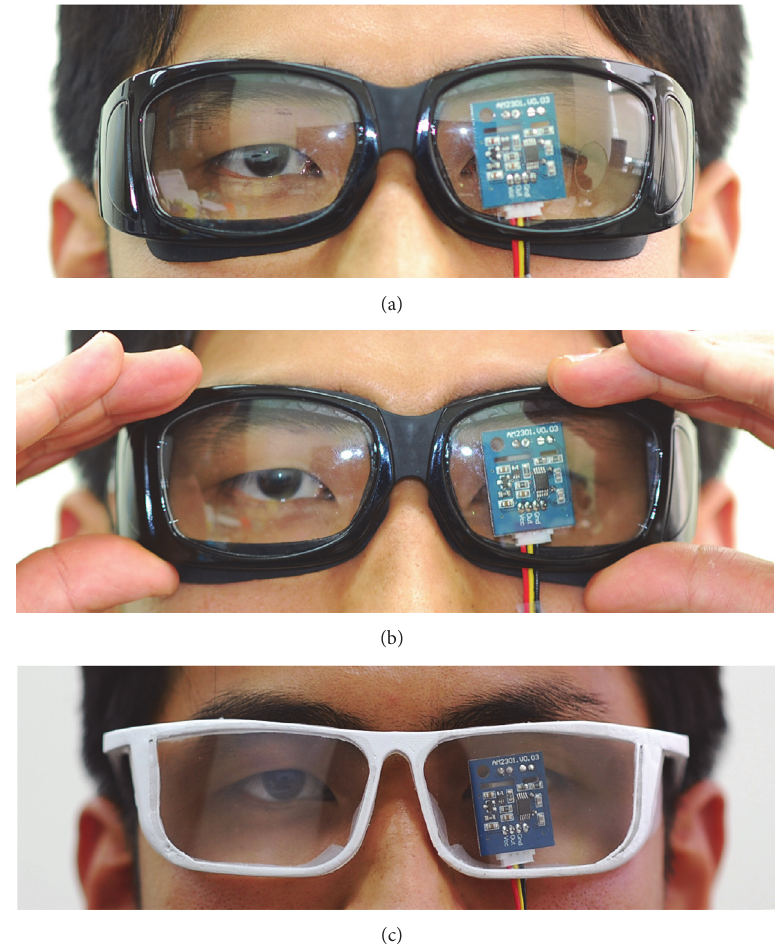
Figure 3: Wearing of moisture chamber spectacles. (a) Natural wearing of uniformed moisture chamber spectacles. (b) Pressurized wearing of uniformed moisture chamber spectacles. (c) Natural wearing of personalized moisture chamber spectacles.